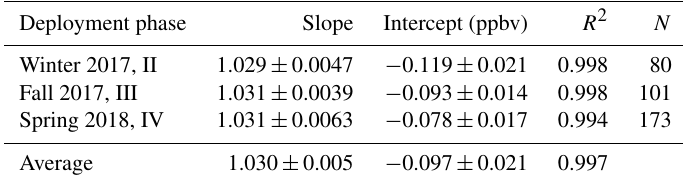
Table 2. Orthogonal linear regressions of the fast CAMS data averaged over the PFP time base vs. the PFP data for three of the field deployment